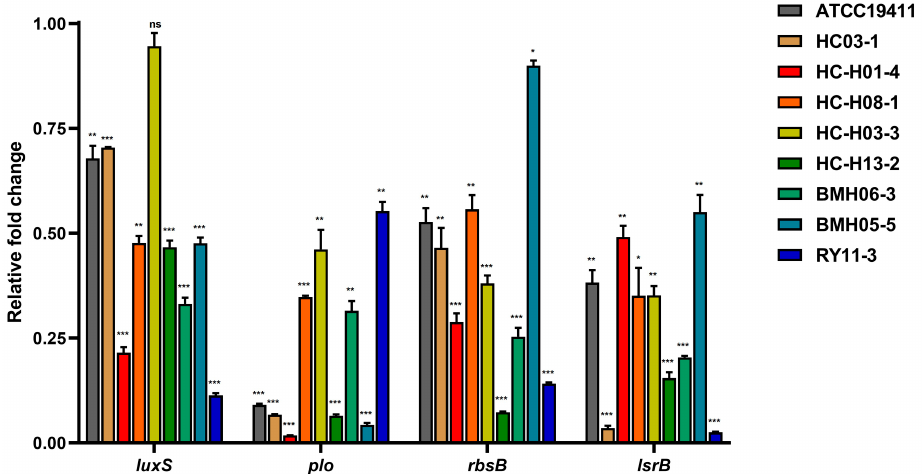
Figure 5. Quantitative real-time RT-PCR analysis of genes involved in biofilm formation of T. pyogenes isolates. Biofilms were formed in the presence of 1/2 MBIC luteolin. Housekeeping genes gapA were used for normalization. Error bars and asterisks indicate the SEM. statistical significance of difference was analysed by t -test (* p < 0.05; ** p <0.01; *** p < 0.001).